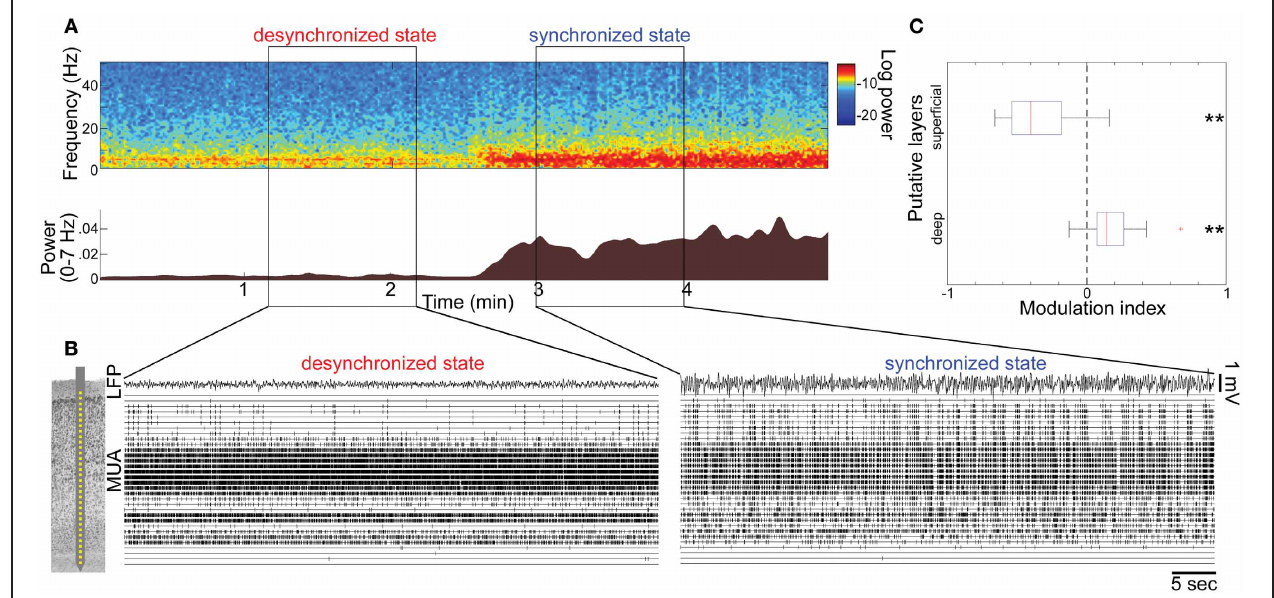
across cortical layers and LFPs during the desynchronized and synchronized state, with a schematic drawing of a 32 site linear electrode. LFP was taken from channel 16, likely located in infragranular layers. (C) Modulation index of spontaneous population activity in putative L2/3 (0–500 µ m from cortical surface) and L5 (800–1100 µ m). ∗∗ p < 0 . 005 ( t